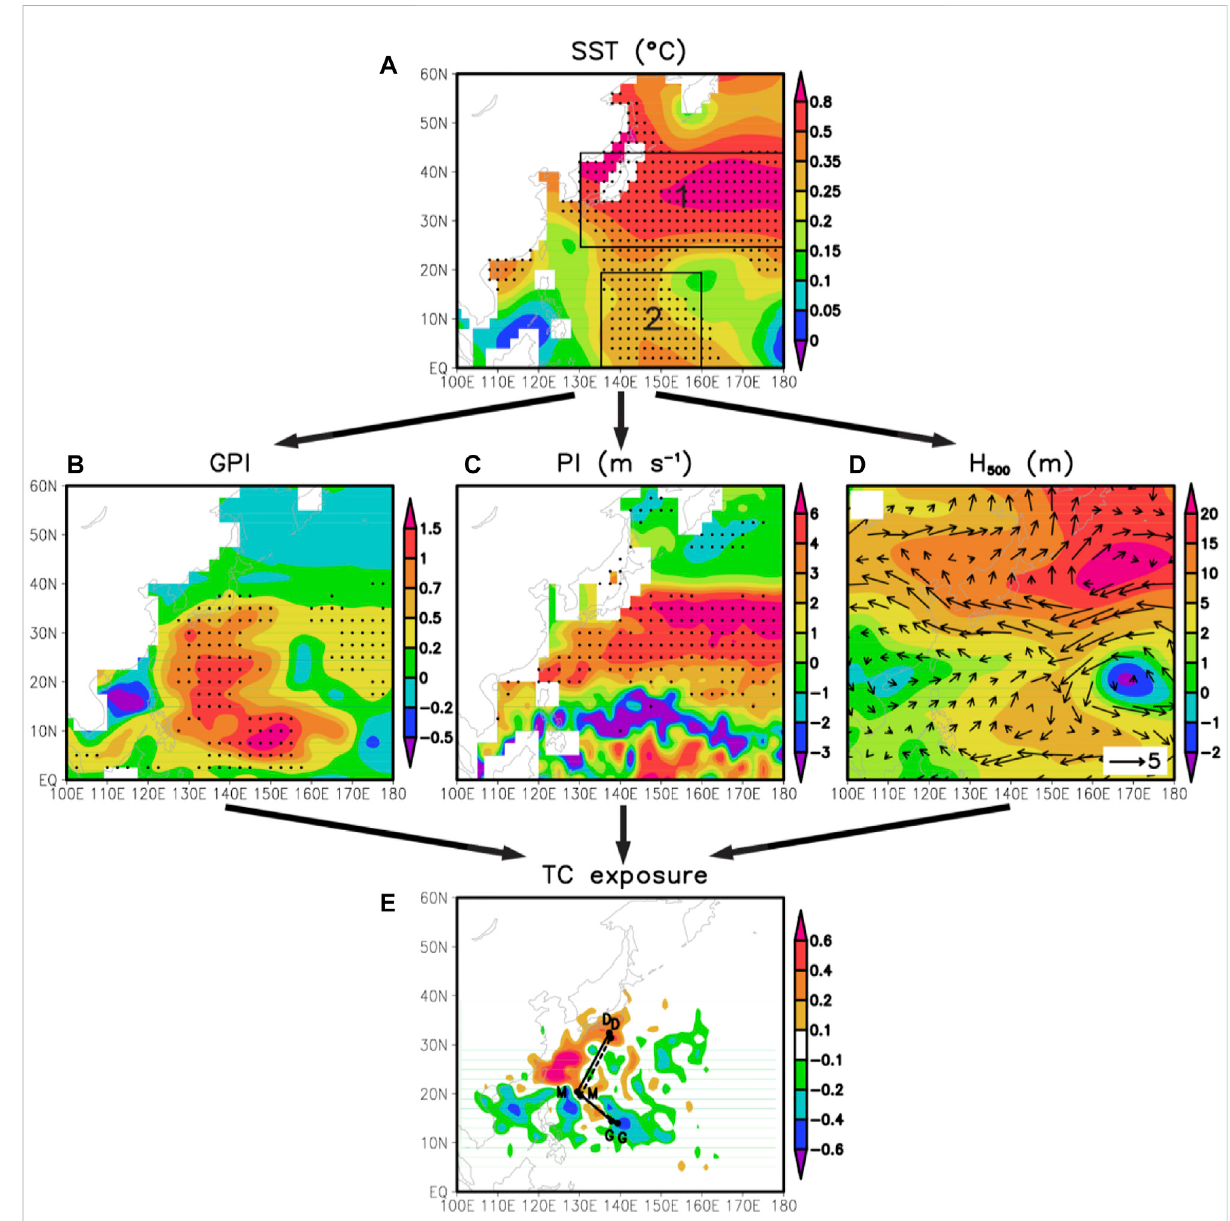
FIGURE 5 Differences in annual-mean JASON SST, GPI, PI, large-scale circulation, and TC exposure between negative IPO phase and positive IPO phase. (A) SST ( ° C), (B) GPI, (C) PI (m s − 1 ), (D) 500-hPa geopotential height (shaded; m) and 850 – 300 hPa vertical-mean wind (vectors; m s − 1 ), and (E) TC exposure(numberofdaysofexposureperyearper2 ° ×2 ° latitude – longitudegridbox)andthepositionsofTCgenesis(G),lifetimemaximumintensity (M), and disappearance (D), which are depicted in dotted line in the positive IPO phase and in solid line in the negative IPO phase. The IPO negative phase refers to the period of 1980-1998, and the IPO positive phase refers to the period of 1999 – 2015. Dotted areas denote that the differencesaresigni fi cantat/abovethe99%con fi dencelevelbytheStudent ’ s t test.BlackboxesindicatethetwomainregionswhereSSTdifferences are signi fi cant at/above the 99% con fi dence (Region 1: 25 ° N-45 ° N, 130 ° E-180 ° E; Region 2: 0 ° N-20 ° N, 135 ° E-160 °